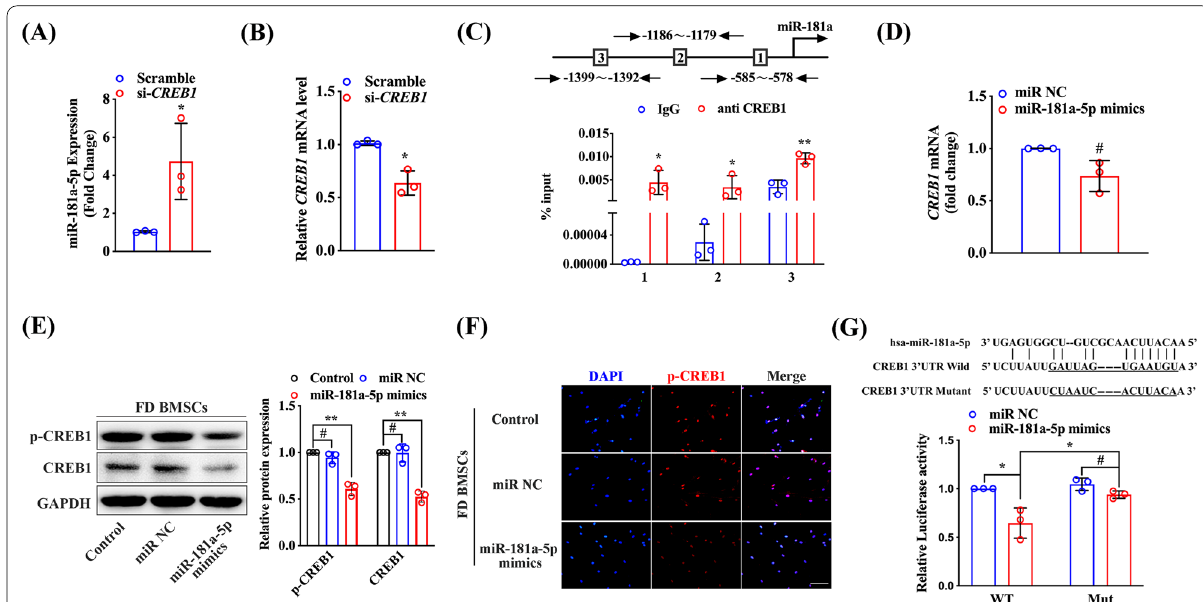
Fig. 5 CREB1 interacts with miR-181a-5p through a feedback loop in FD BMSCs. After si- CREB1 treatment for 48 h, CREB1 ( a ) and miR-181a-5p ( b ) in FD BMSCs were detected by quantitative real-time PCR. c Three primers were designed to cover the miR-181a promoter region and were used to identify CREB1 binding sites in the ChIP assay. All three putative CREB1 binding sites in the miR-181a promoter region were identified. d CREB1 mRNA expression was detected by real-time PCR in FD BMSCs transfected with miR-181a-5p mimics. e Protein expression of CREB1 and p-CREB1 was detected by western blot. f Immunofluorescence analysis of p-CREB1 expression in FD BMSCs transfected with miR-181a-5p mimics. g Effect of miR-181a-5p on a dual-luciferase reporter plasmid bearing wild-type (WT)/mutated (Mut) CREB1 binding sites was analyzed. Cells were cotransfected with either WT-CREB1 or Mut-CREB1 and miR-181a-5p mimics or miR NC. Firefly and Renilla luciferase activities were measured in cell lysates. Scale bar, 100 μm. The data are presented as the mean S.E.M. values (n 3). * P < 0.05; ** P < 0.01; # P > ± =